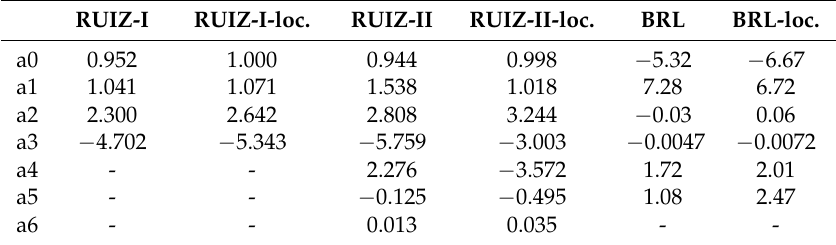
Table 5. Coefficients obtained by local calibration of RUIZ-I, RUIZ-II and BRL models (cf. formulas in Section 2.2). Original coefficients are also reported for comparison. See Table 1 for the model acronyms. RUIZ-I RUIZ-I-loc. RUIZ-II RUIZ-II-loc. BRL